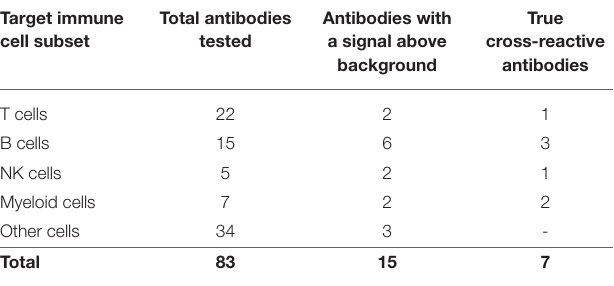
TABLE 1 | List of antibodies tested by FACS. Target immune cell subset